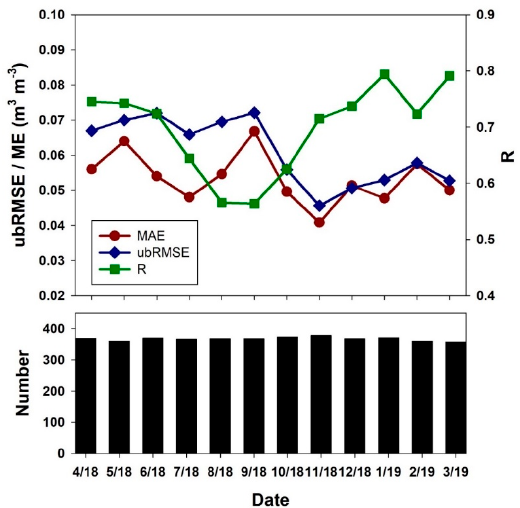
Figure 11. Comparisons of ubRMSE, MAE, and R between the SM derived from CYGNSS and the in situ measurements.